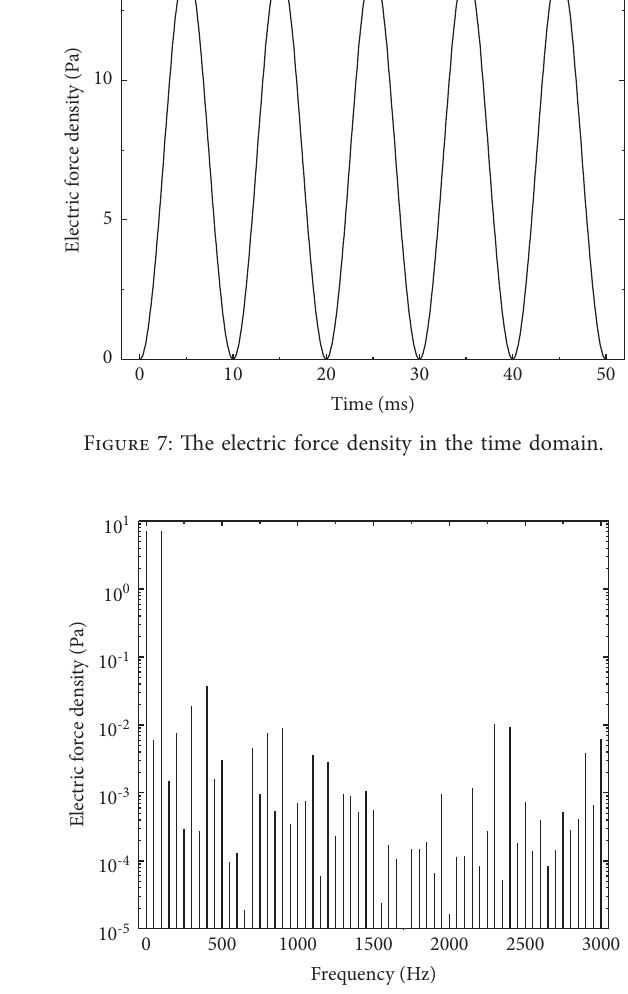
Figure 8: The electric force density in the frequency